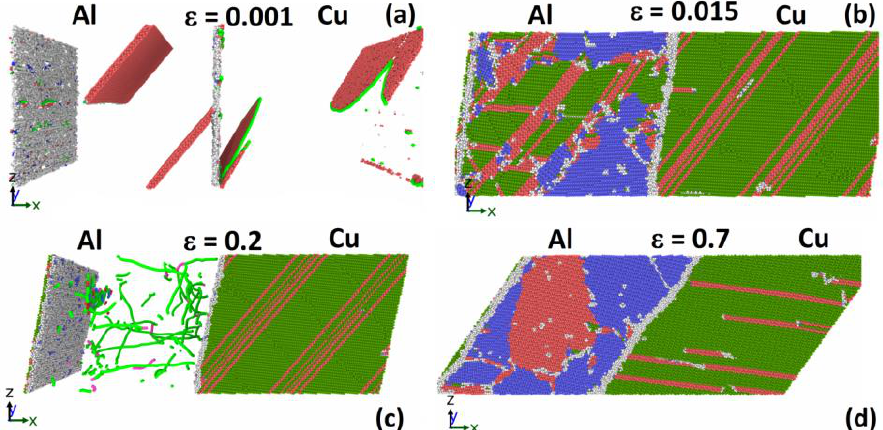
Figure 20. Development of plastic deformation in Al-Cu composite with the (110)+misorientation interface at the initial pressure of 40 GPa: ( a ) Plasticity initiation in Al; ( b ) penetration of plasticity into Cu part; ( c ) generation of secondary dislocations and vacancies in Al; ( d ) absorption of stacking faults in Cu by the interface. The misorientation angle is 12.1 ◦